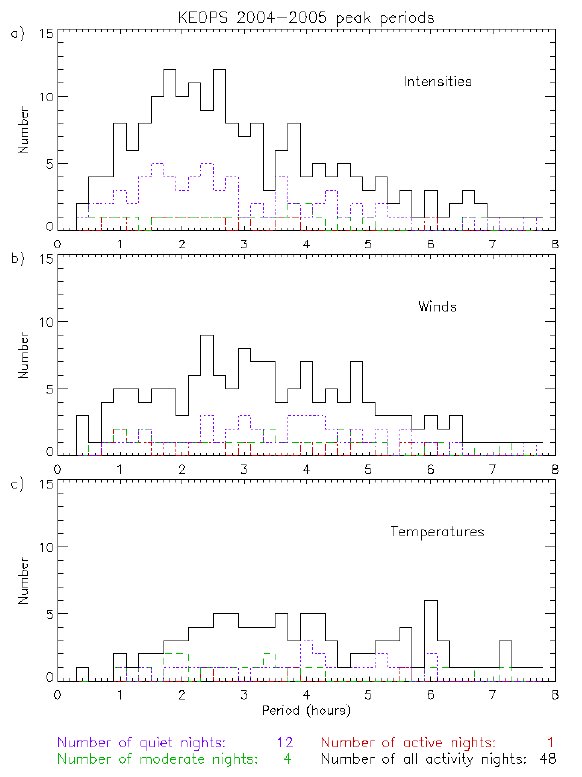
Fig. 7. Histogram of gravity wave periods for all nights and all activity levels, from KEOPS data over the winter season of 2004– 2005: (a) intensities, (b) winds, and (c)